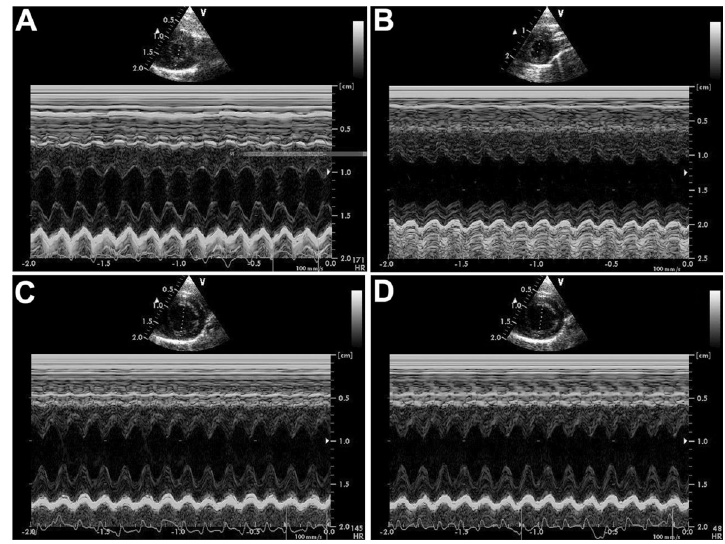
Figure 1. Echocardiography findings (M-mode, horizontal section of LV short axis). A , Control group; B , CHF group; C , low-dose rhBNP group; D , high-dose rhBNP group. CHF: chronic heart failure; rhBNP: recombinant human brain natriuretic